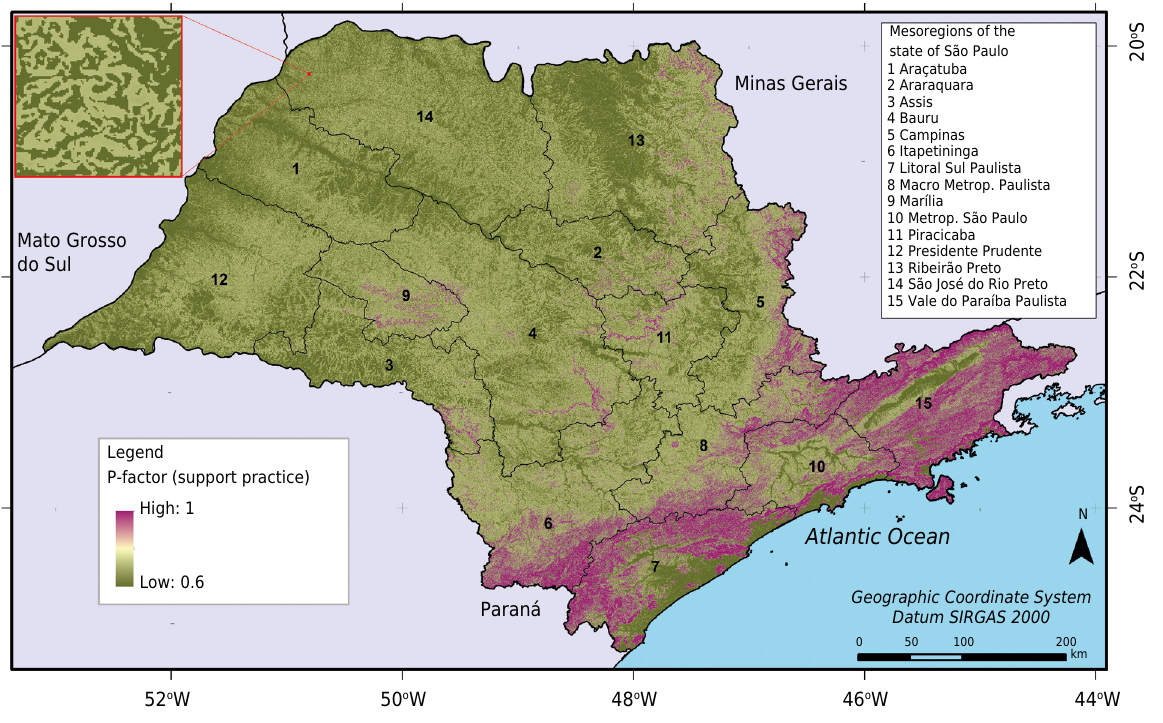
Figure 9. P-factor map of the state of São Paulo.